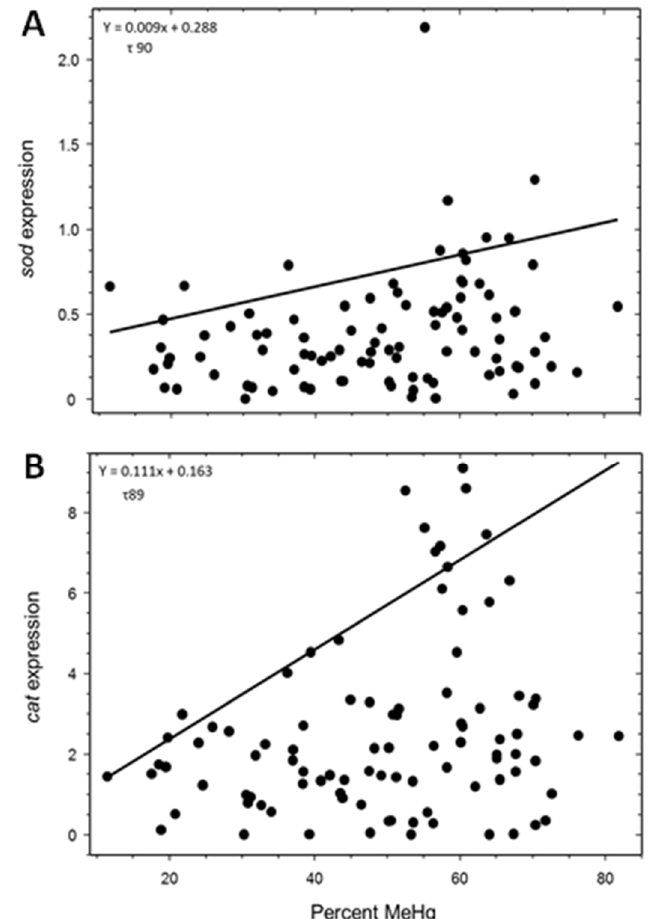
Figure 4. Quantile regression analysis between normalized ( A ) sod ( τ 90; p = 0.013; n = 94) and ( B ) cat ( τ 89; p = 0.041; n = 92) expression and percent total mercury as methylmercury (MeHg) in livers of northern pike.